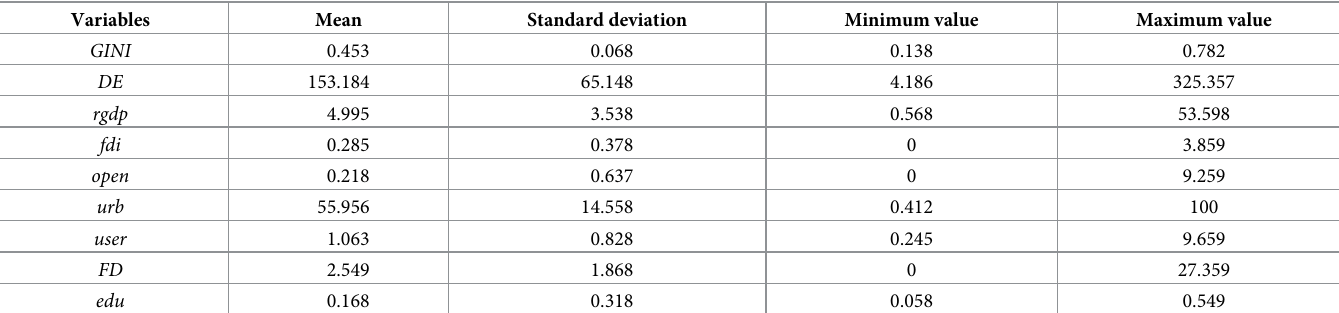
Table 1. Descriptive statistics of the main